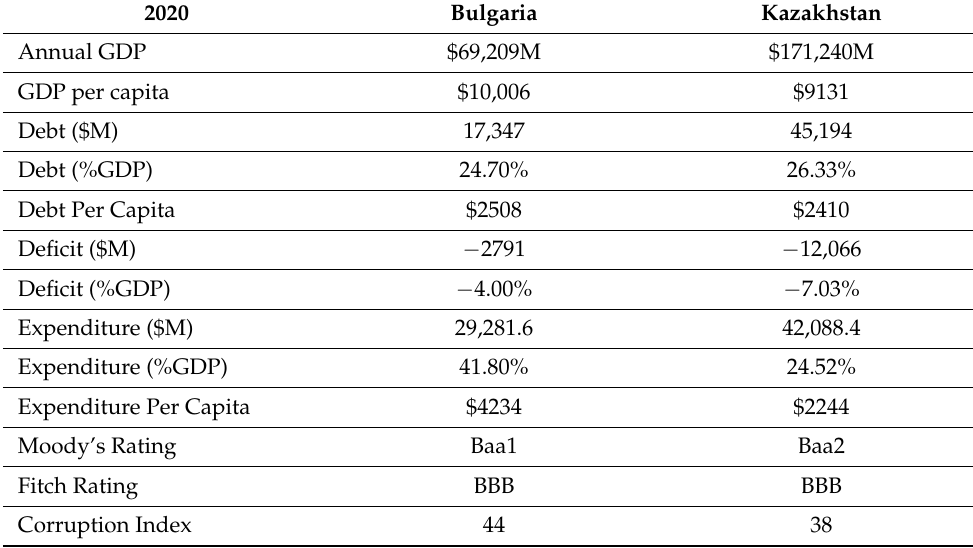
Table 8. Macroeconomic indicators for the national economies of Bulgaria and Kazakhstan.